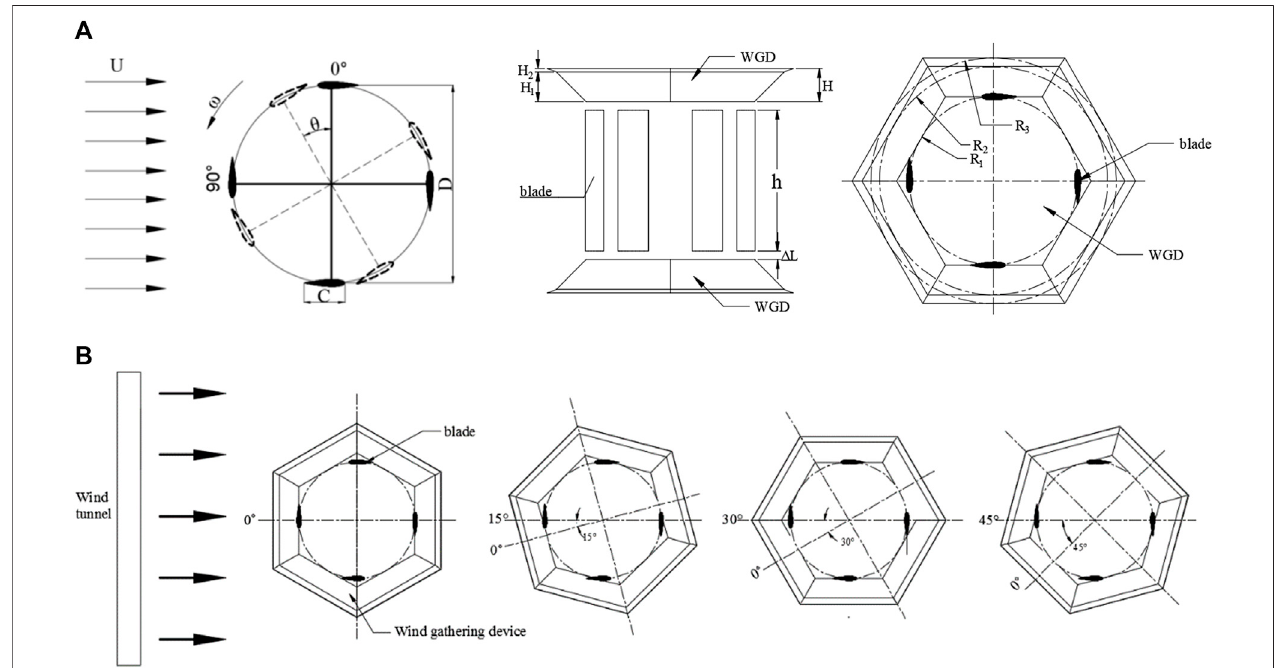
FIGURE 2 | Schematic of the WGD and